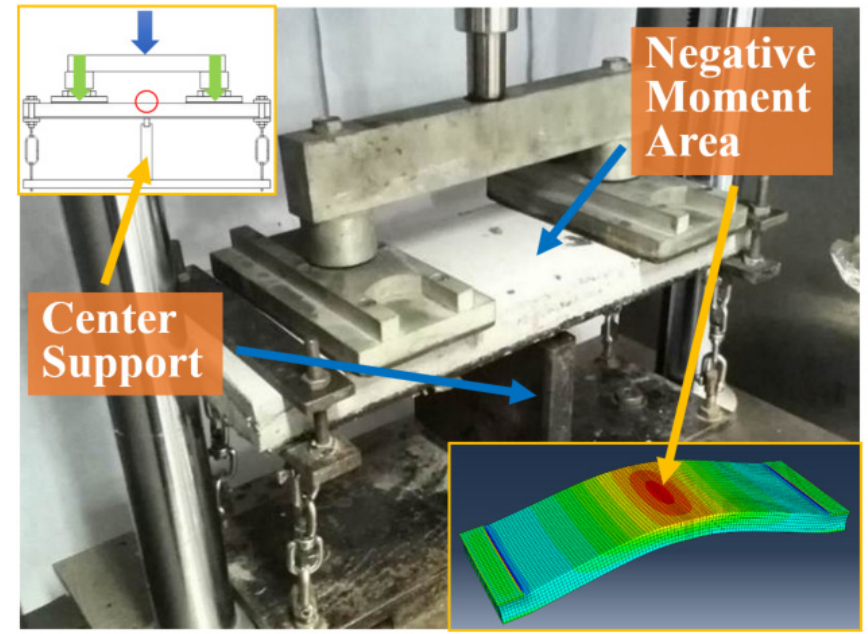
Figure 11. ECC-steel composite specimen fatigue test according to orthotropic steel bridge deck (OSBD) pavement actual working conditions.